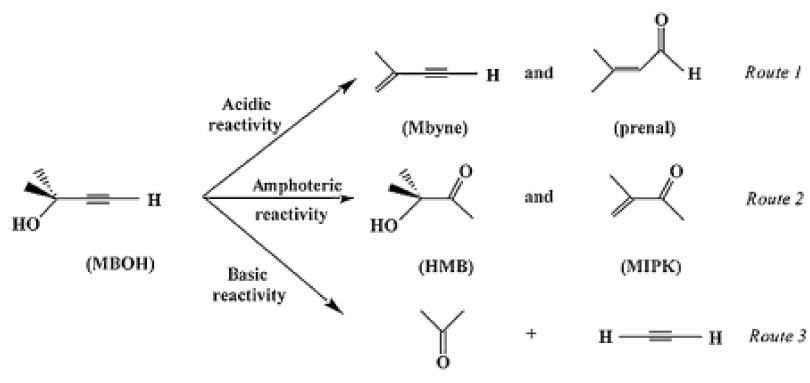
Figure 8. Scheme of 2-methyl but-3-en-1-yn-2-ol (MBOH) reaction pathways for an acid-base catalyst Reproduced from [59] copyright 2016, Taylor &